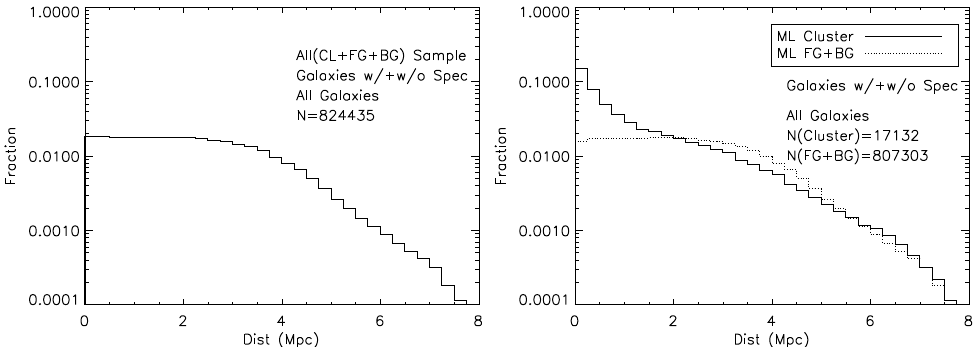
Figure 12. Sampling bias in our Subaru catalog itself. Total sample distribution as a function of the cluster-centric distance ( left panel) and the cluster memberships assigned by the MLP best model ( right panel), corresponding to our sample with or without